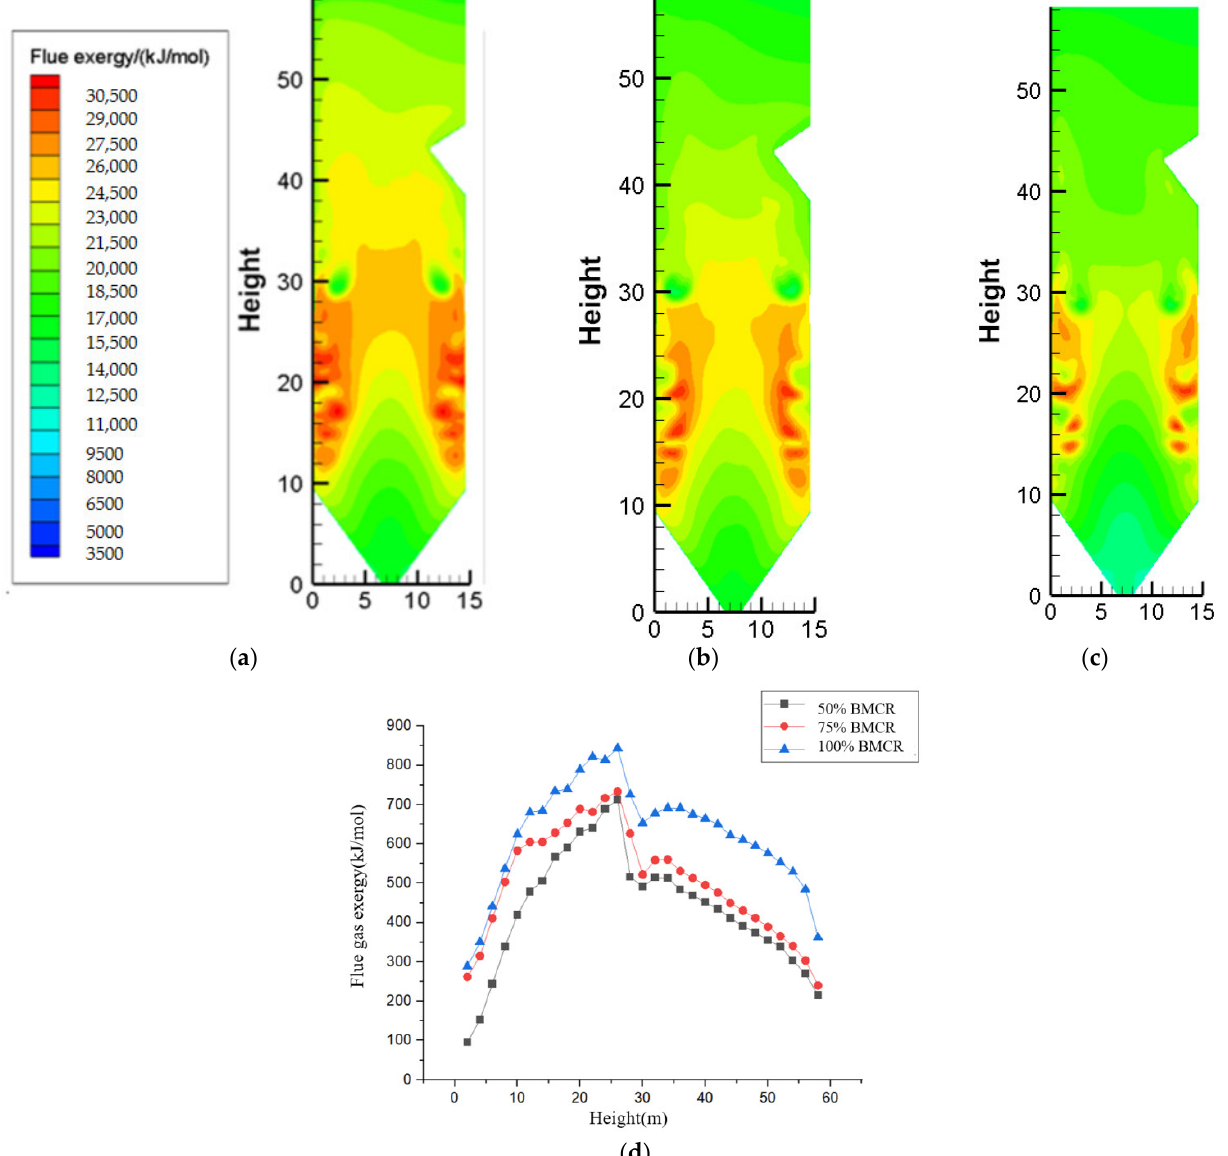
Figure 4. Distribution of flue exergy and flue gas exergy under different loads. (a) 100%BMCR. (b) 75%BMCR. ( c ) 50%BMCR. (d) Distribution of flue gas on the height of the furnace.